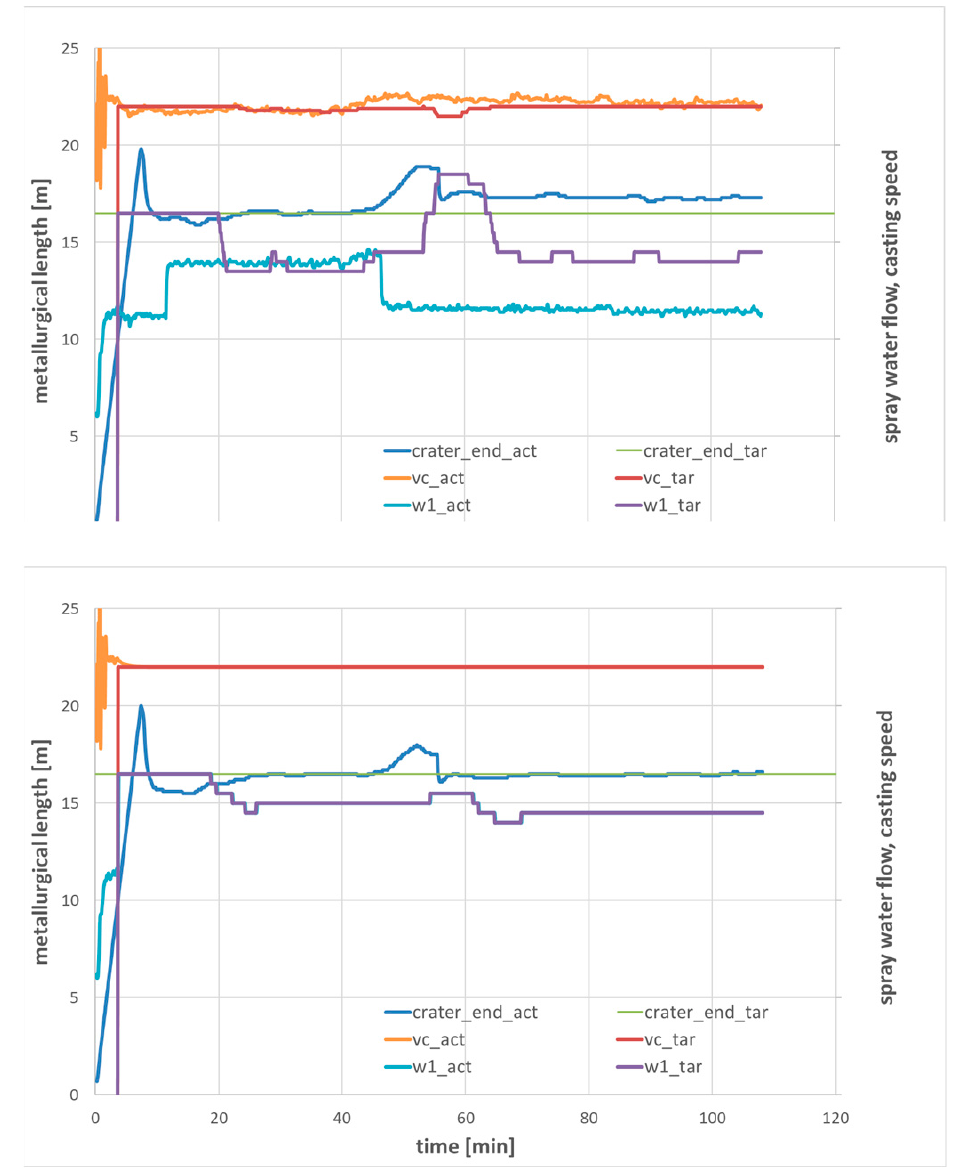
Figure 20. Evolution of actual and target casting speed, spray water flow and crater end position without ( top ) and with ( bottom ) application of target casting parameters for target crater end of 16.5 m at ESF billet